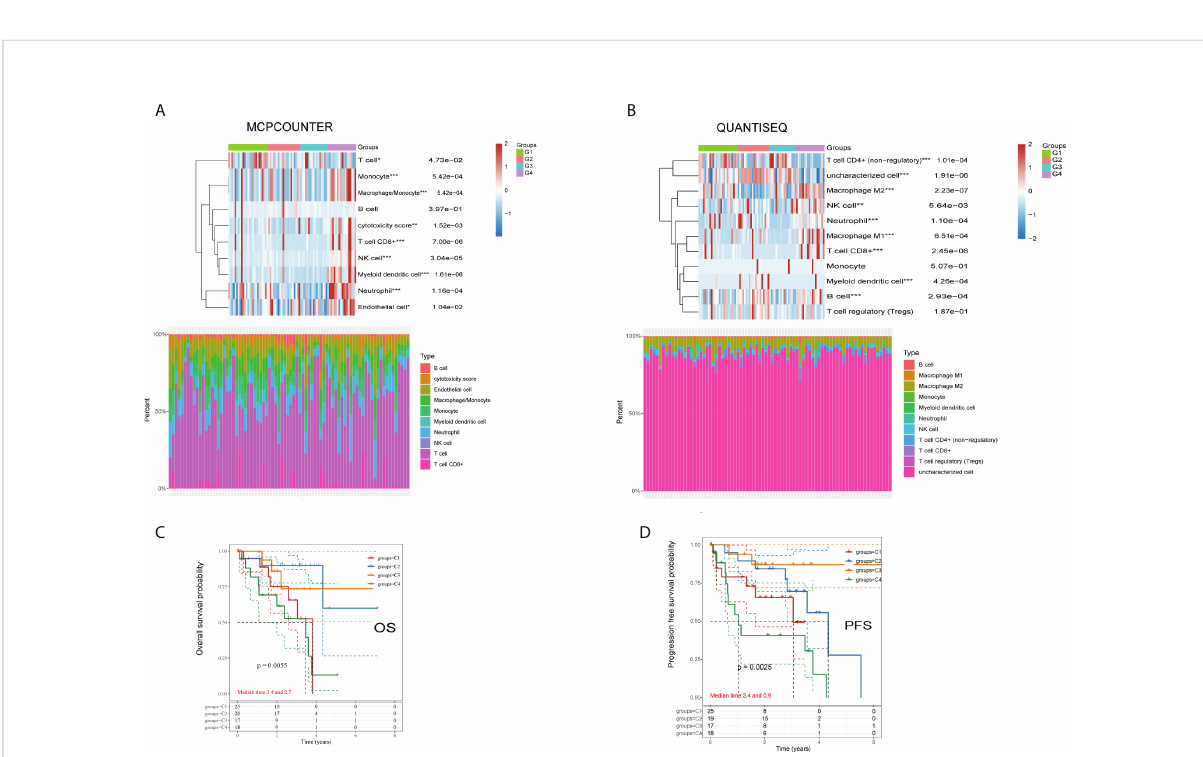
FIGURE 2 Differences of immune cells using QUANTISEQ and MCPCOUNTER algorithms, and overall survival and disease-free survival analysis in four groups. (A) MCPCOUNTER algorithms showed the differences of immune cells in different groups of samples. (B) QUANTISEQ algorithms showed the differences of immune cells in different groups of samples. (C) Kaplan-Meier OS survival analysis of the four different subtypes. (D) Kaplan-Meier PFS survival analysis of the four different subtypes. *p<0.05, **p<0.01, ***p<0.001.